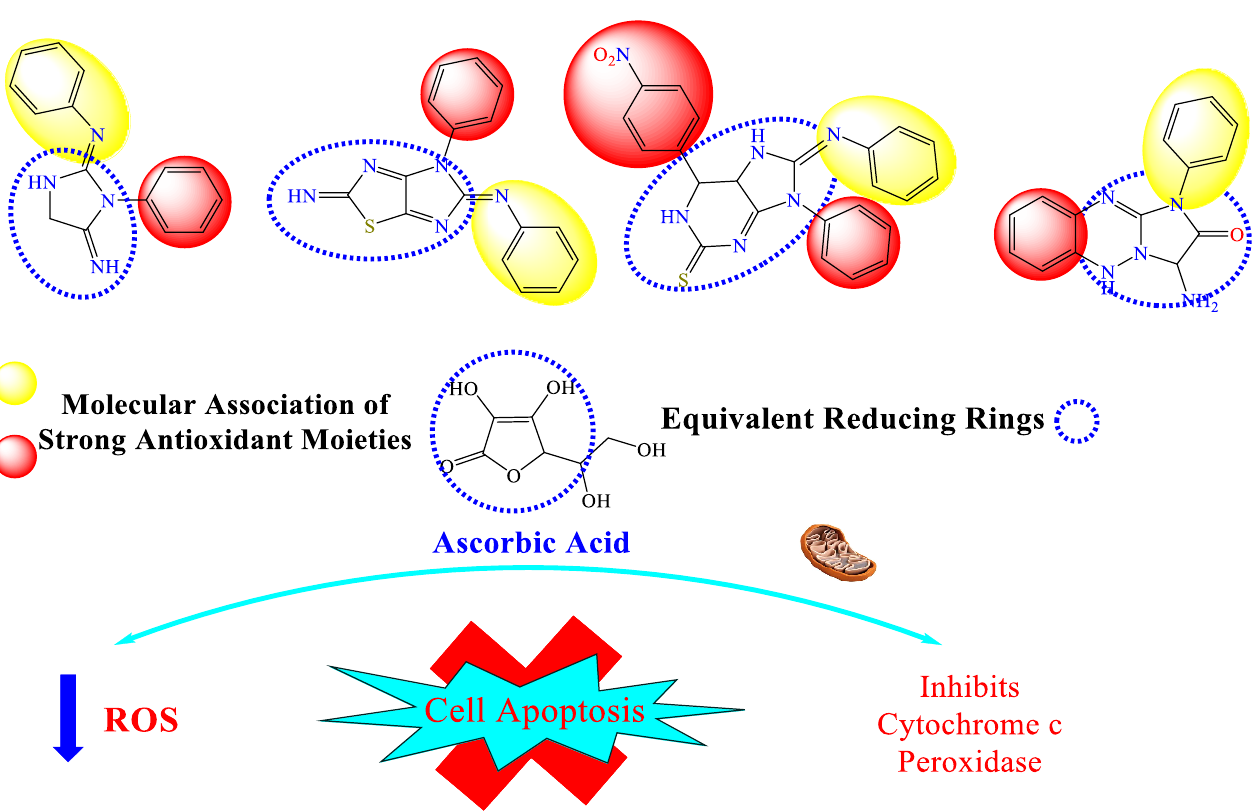
Figure 1. The rationale of the newly synthesized imidazole and thiazol derivatives using molecular association.